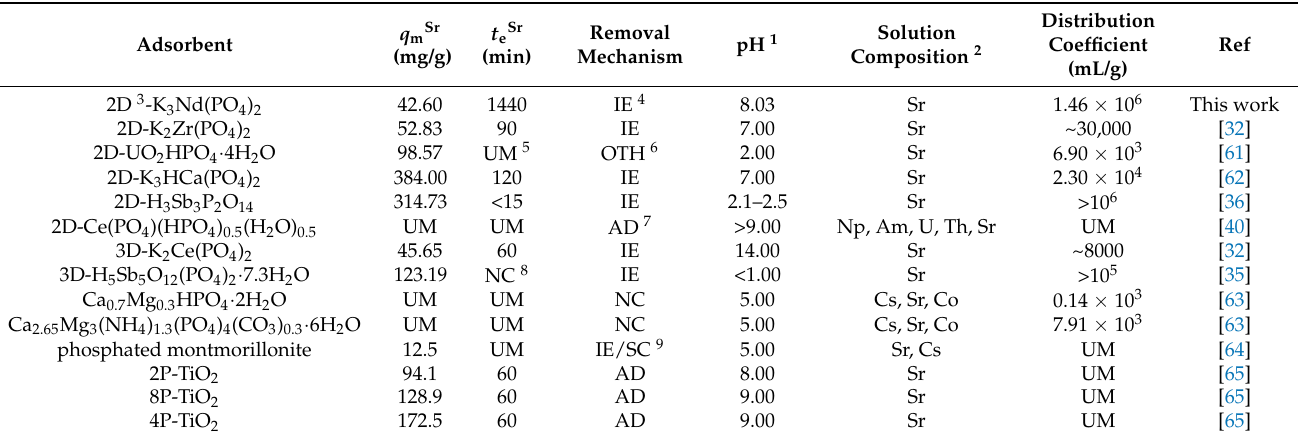
Table 2. The comparison of the adsorption abilities of K 3 Nd(PO 4 ) 2 and other reported adsorbents for Sr 2+